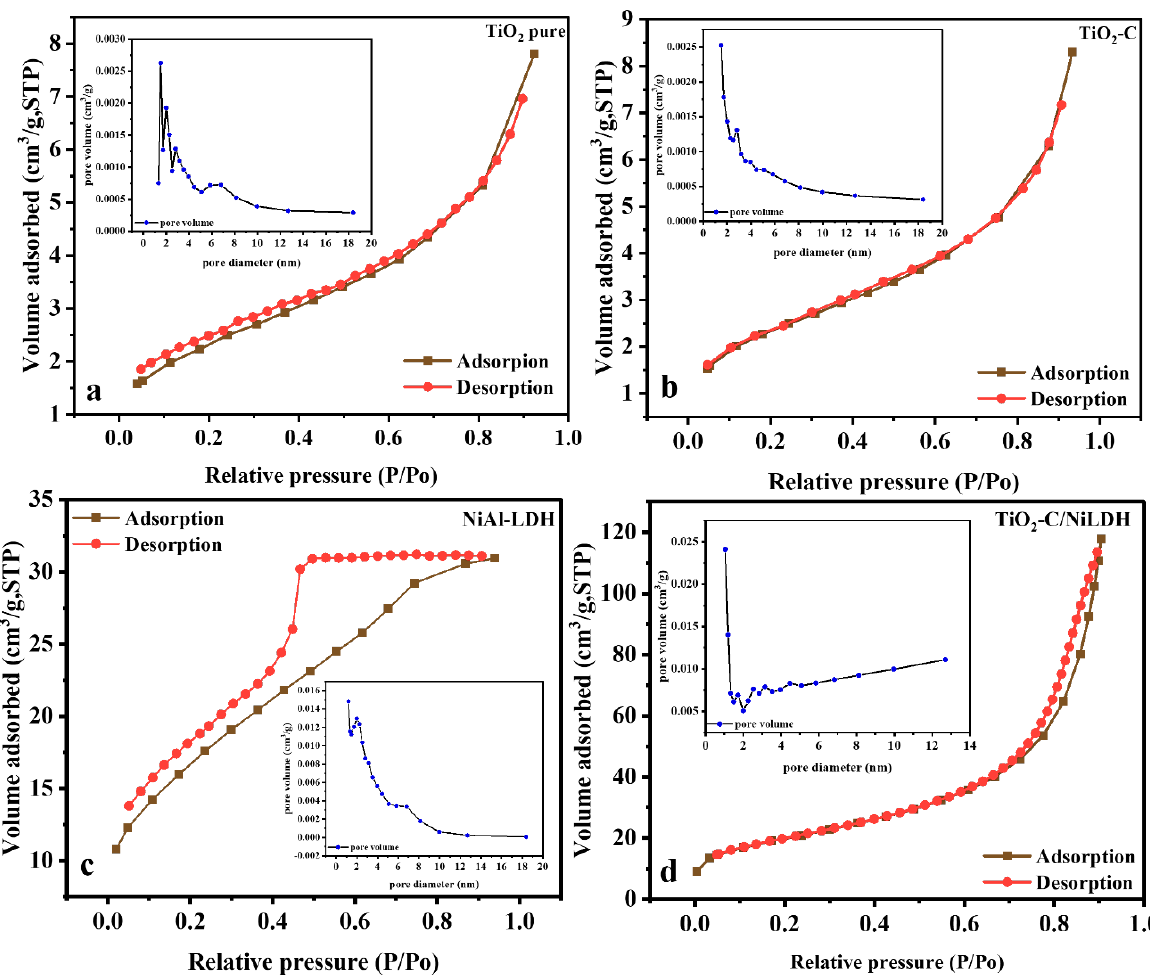
Figure 7. N 2 adsorption/desorption isotherms and pore size distribution inset the figures for all the investigated solids: ( a ) TiO 2 pure sample, ( b ) TiO 2 -C sample, ( c ) NiAl-LDH sample, ( d ) TiO 2 -C/NiLDH